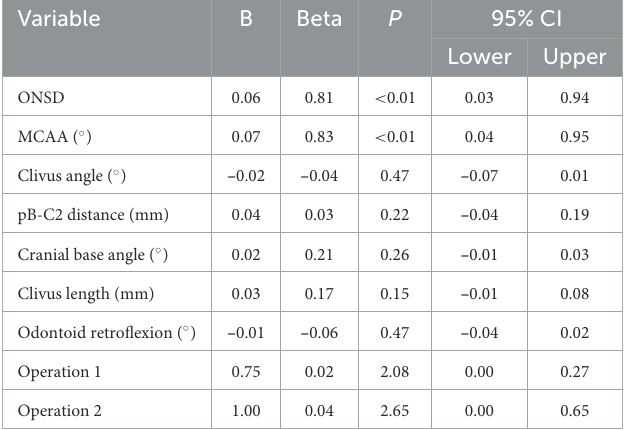
TABLE 4 The multiple linear regression modal of ONSD and other craniovertebral junction parameters with CCOS (operations used as dumb variable).